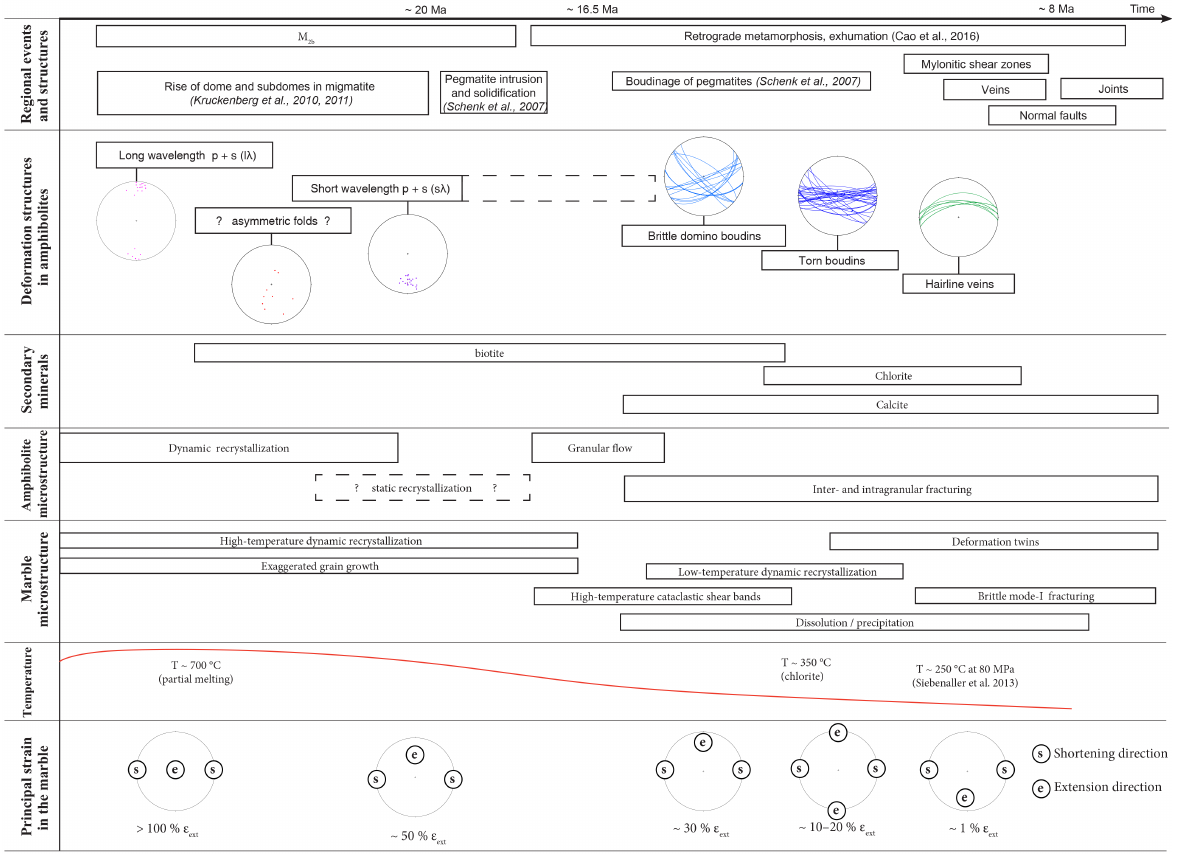
Figure 15. Overview of the results of this study in temporal relation to each other and to regional events. Note that only the relative order of events is considered and the time axis and temperature curve are not to scale. Results are grouped in rows; overlapping boxes are interpreted as contemporaneous. Data on temperature and regional events and structures are compiled from Buick and Holland (1991), Katzir (1999), Schenk et al. (2007), Kruckenberg et al. (2010, 2011) and Cao et al.